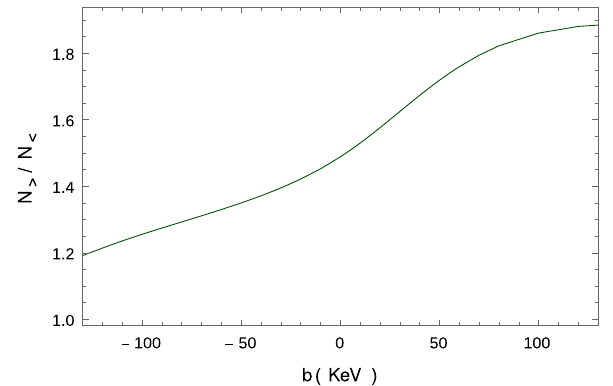
Fig. 11 Asymmetry N > / N < as a function of the binding energy of the X(3872) for (cid:9) non = 100